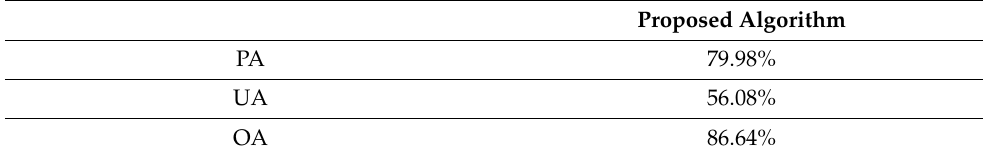
Figure 18. Extraction effectiveness of the proposed algorithm. Table 3. Accuracies for the proposed algorithm.